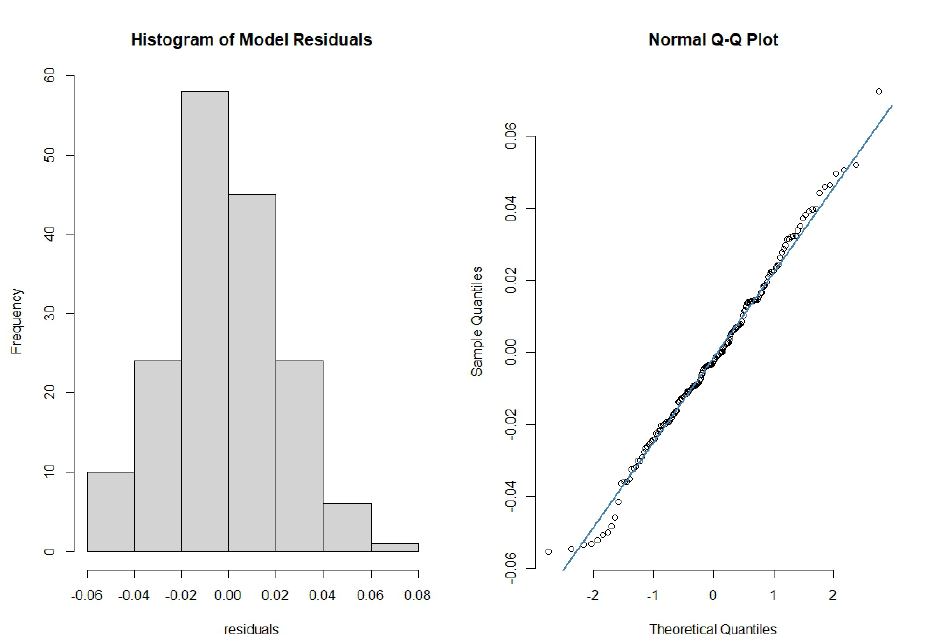
Figure 5. Shapiro-Wilk normality test, W = 0.99288, p -value = 0.5819. There is no significant deviation from normal